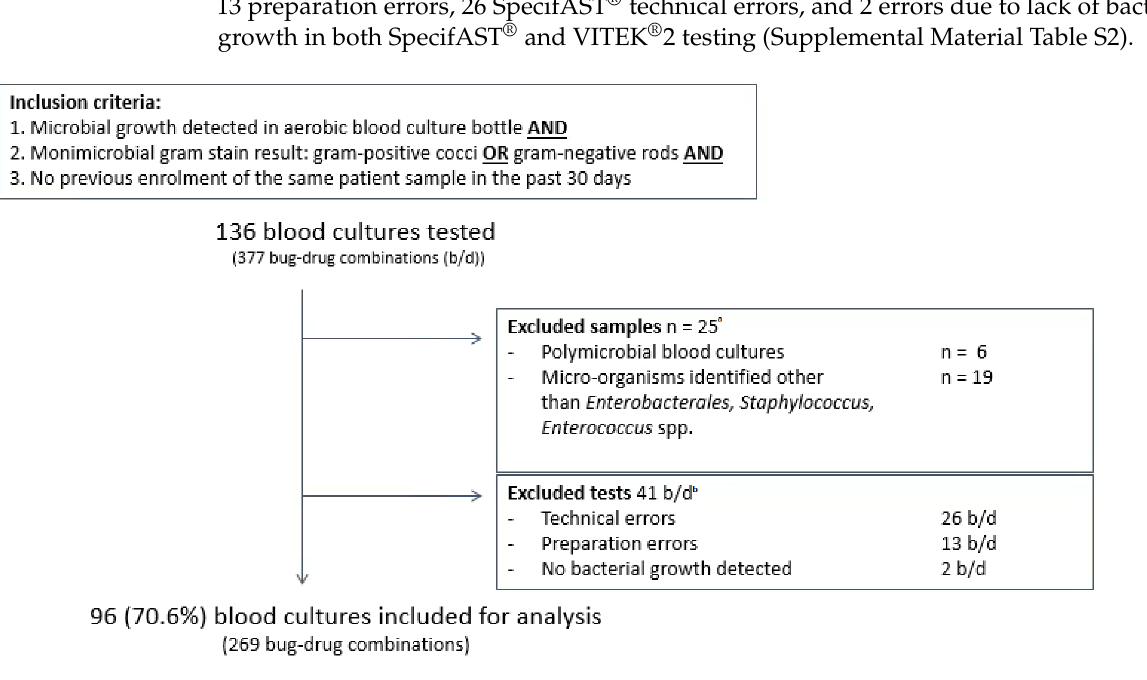
Figure 3. Baseline figure in and excluded samples. Inclusion criteria were microbial growth detection in aerobic blood culture bottles and monomicrobial gram stain result with gram-positive cocci or gram-negative rods and no previous enrolment of the same patient in the past 30 days. Exclusion criteria were polymicrobial blood cultures, micro-organisms, other than Enterobacterales spp., Staphylococcus spp. or Enterococcus spp., and errors leading to missing data. Error details are provided in Supplementary Table S2. B/d: bug–drug combinations. a 25 blood culture samples and all corresponding b/d combinations (67) were excluded from analysis based on polymicrobial growth or micro-organism identification result. b In 15 blood culture samples, all b/d combinations were excluded from analysis due to errors or absence of microbial growth. In 2 blood culture samples, one or more b/d combinations were excluded from analysis due to errors or absence of microbial growth. In total, 41 b/d combinations were excluded.